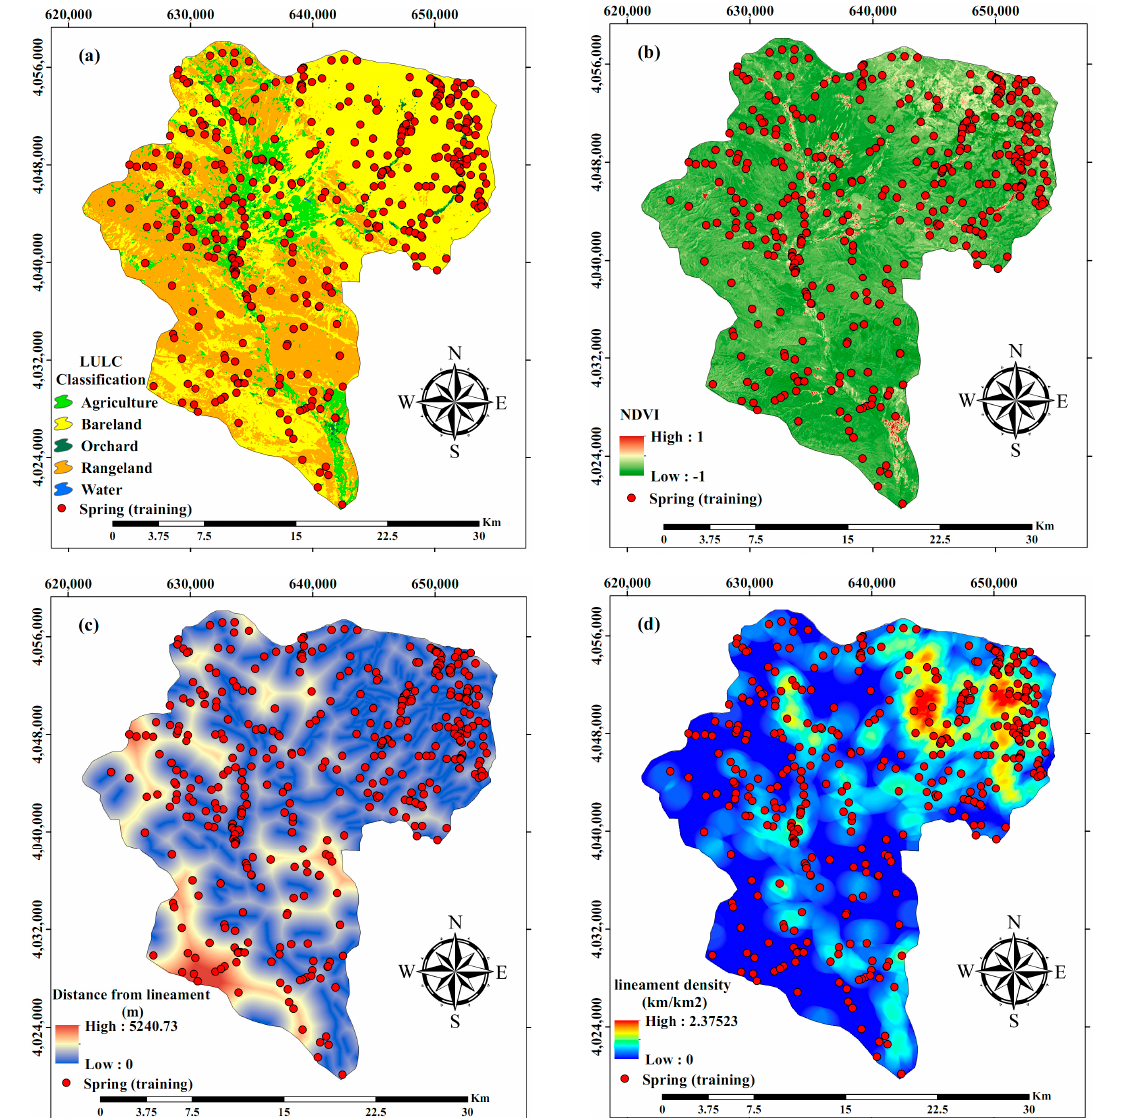
Figure 5. Remote sensing (RS)-derived factors including: ( a ) LULC, ( b ) Normalized difference vegetation index (NDVI), ( c ) distance from lineament, and ( d ) lineament density.